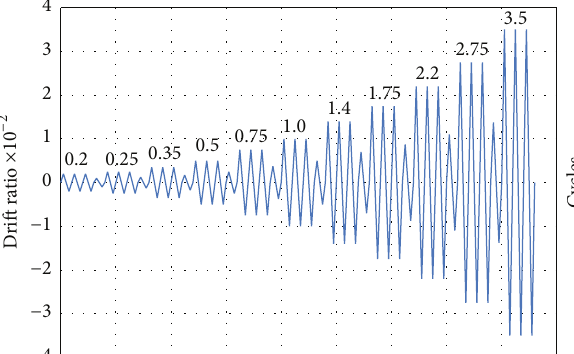
Figure 5: The cyclic lateral displacement pattern (the loading